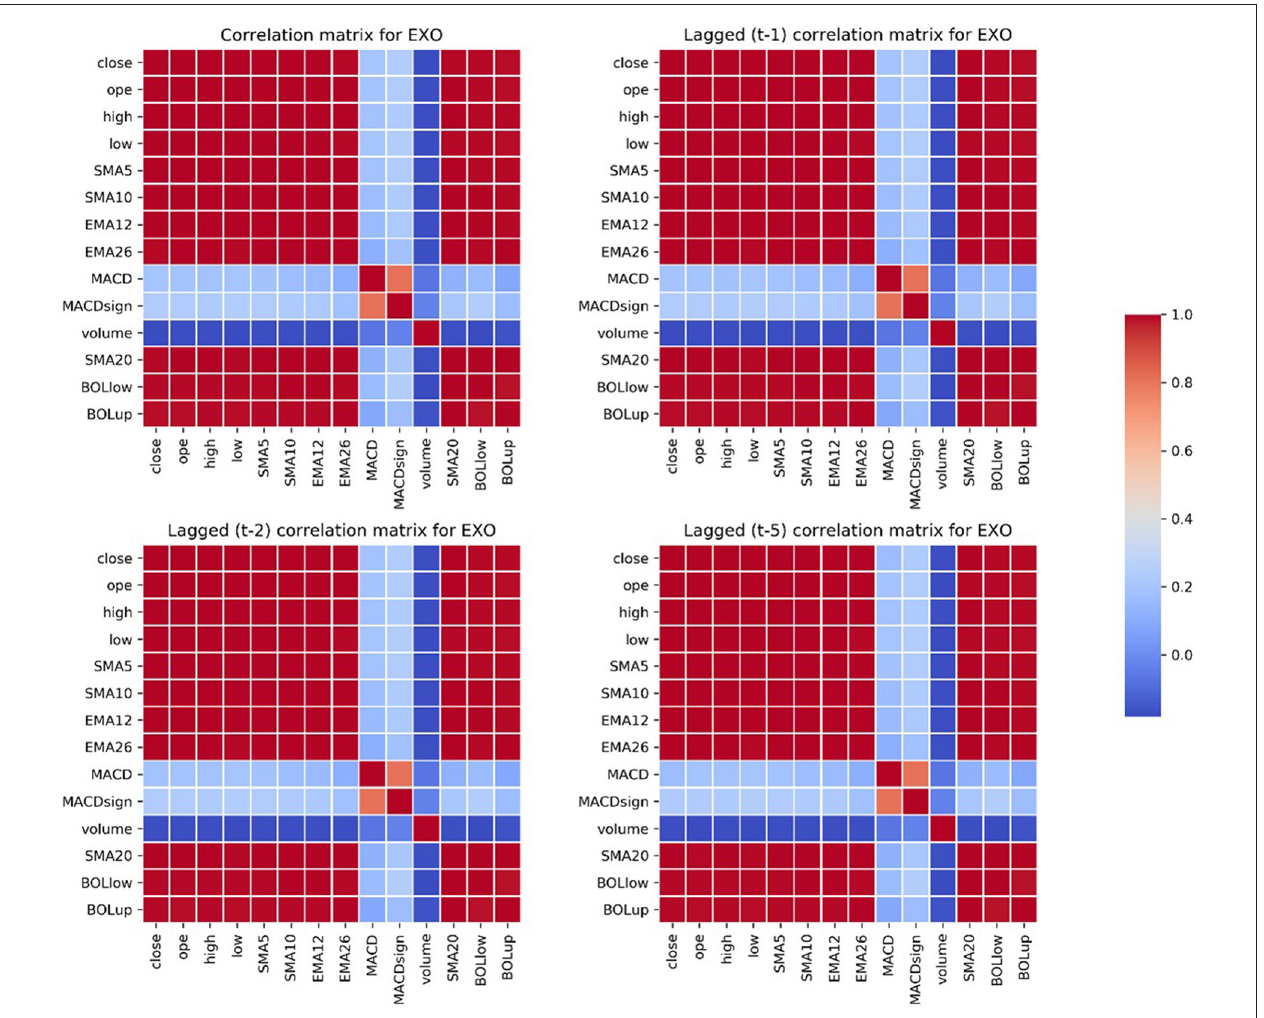
FIGURE 4 | Contemporaneous and lagged correlation matrices for EXO of the selected variables. 0.0004, and the learning rate of the generator η G to